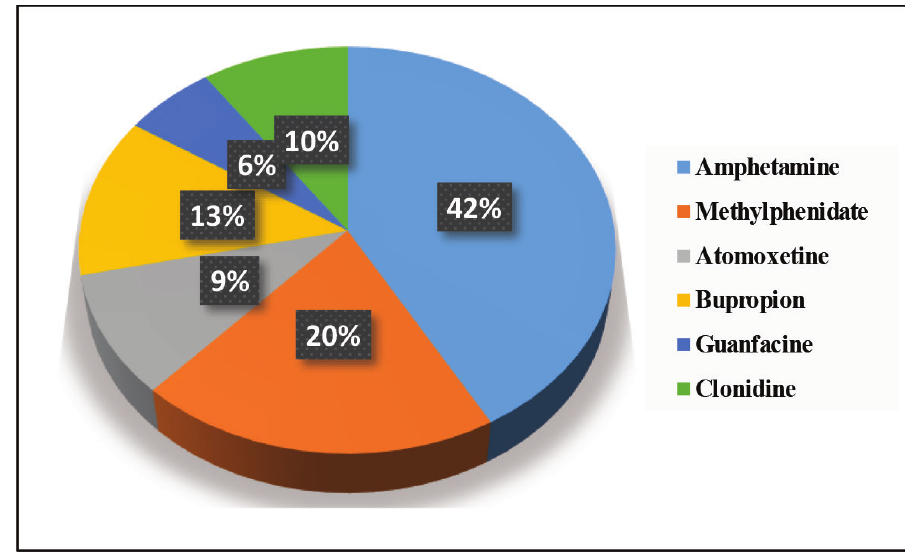
Figure 2: Availability of reported analytical methods for ADHD